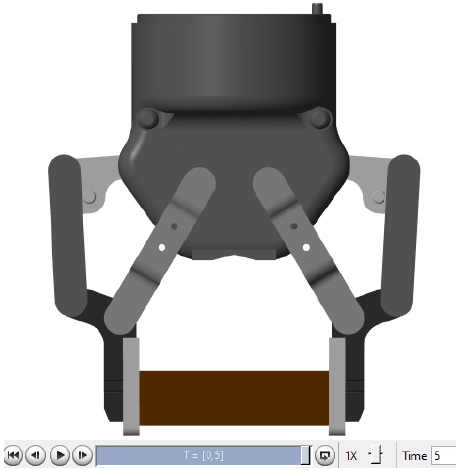
Figure 6. The model of the gripper in SimMechanics.